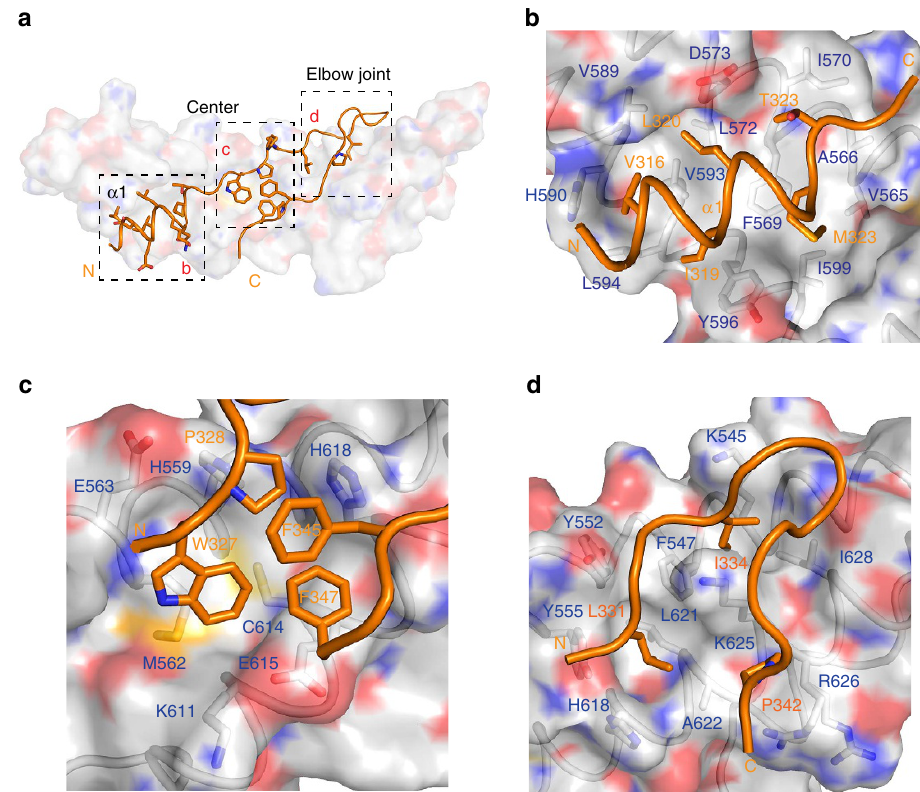
Figure 2 | AFF4 ELLBow –ELL2 Occ interaction surfaces. ( a ) Overview of the main binding determinants of the AFF4 ELLBow. ( b ) The first helix of the ELLBow (orange) binds in a hydrophobic groove on ELL2 (grey). The key residues are shown in a stick model. ( c ) The central cluster, in which hydrophobic residues of the ELLBow pack against ELL2 and one another, and are supplemented by polar interactions. Water molecules are shown as red spheres. ( d ) The ELLBow joint.